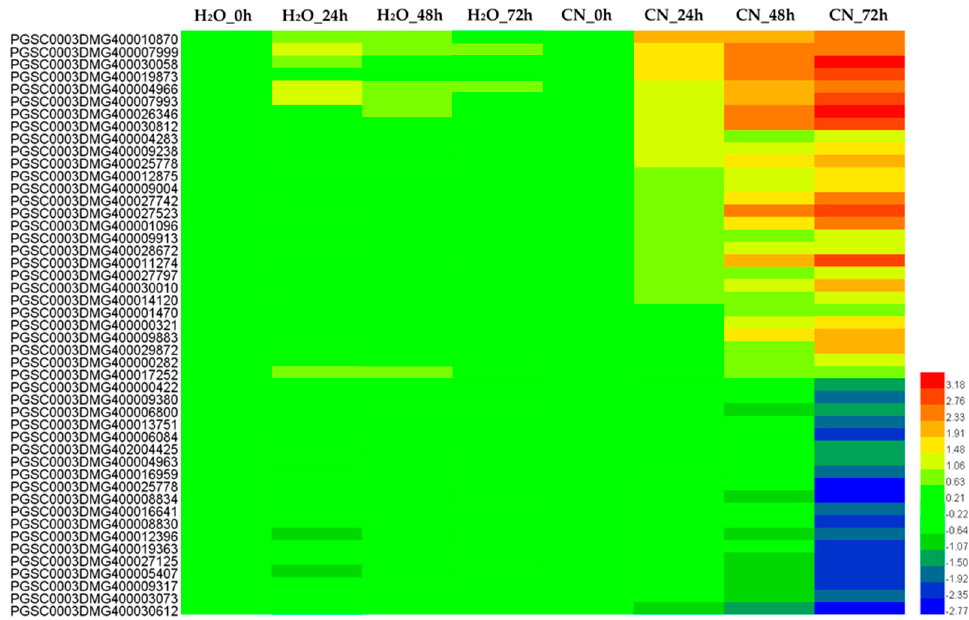
Figure 4. GO classification of annotated DEGs. X -axis, three major functional categories of GO terms: biological process, molecular function, and cellular component; Y -axis, terms with percentages of DEGs in the major category.